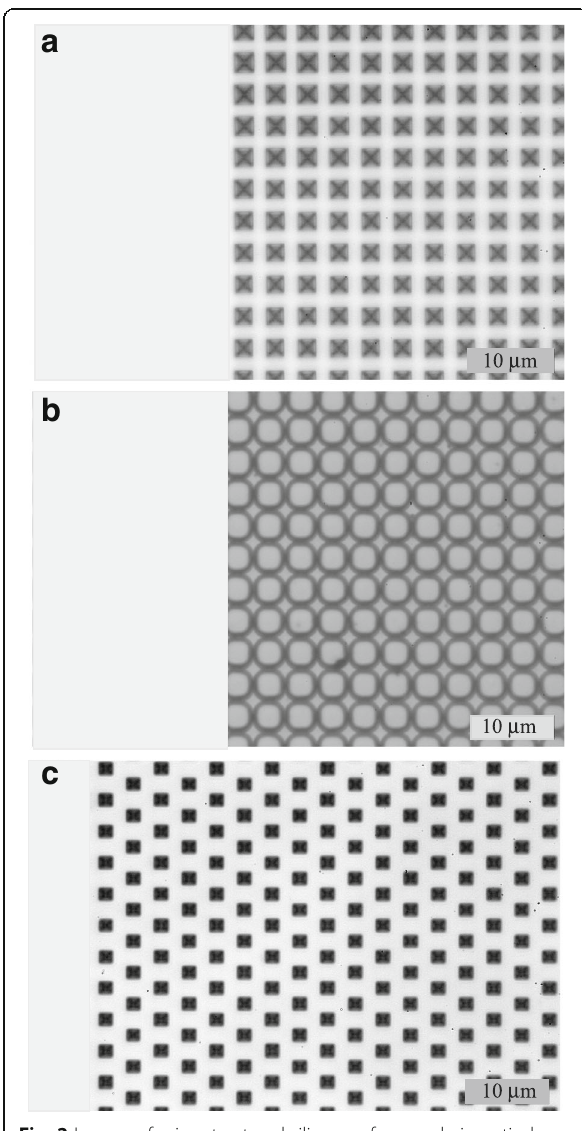
Fig. 2 Images of microstructured silicon surface made in optical microscope. Micropyramids have the following shapes: regular pyramids (1), pits (2) and slightly truncated pyramids